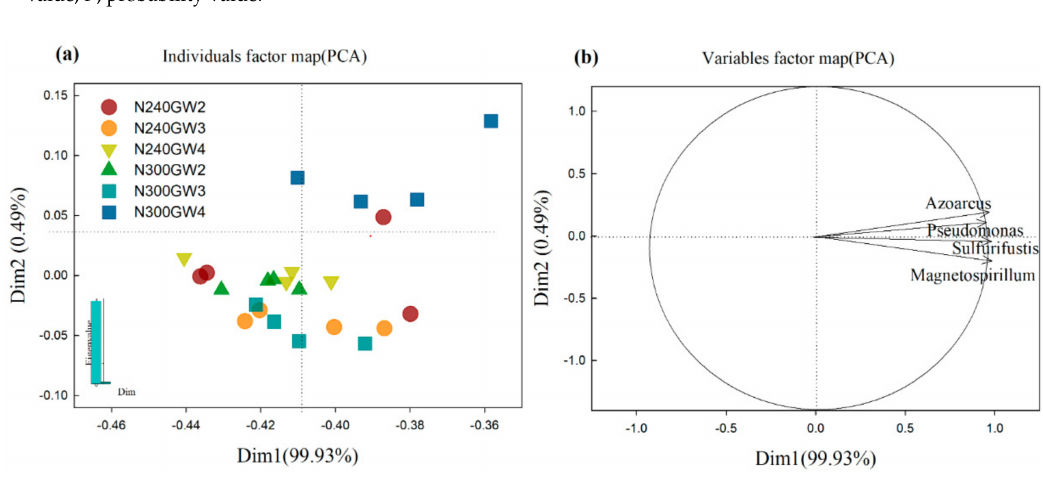
Figure 3. Individuals and variables graph in principal component analysis for nir S-type denitrifier communities. We used taxonomic abundances data from 4 nir S-type dominant genera (relative abundance greater than 1.0%) as quantitative variables, which were used to perform the PCA.